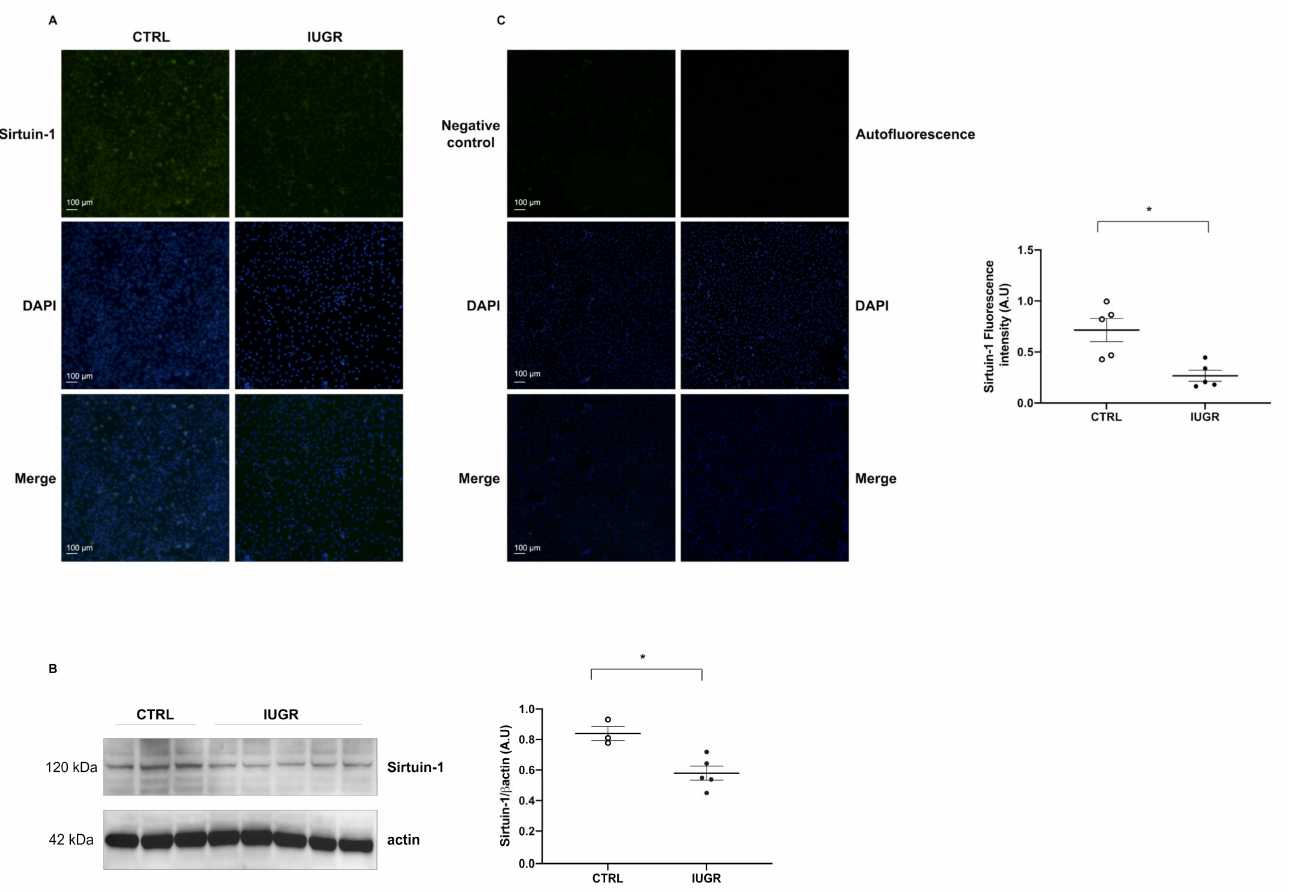
Figure 11. Sirtuin-1 expression. Sirtuin-1 protein expression was measured using immunofluorescence in CTRL-ECFCs and IUGR-ECFCs isolated from six-month-old male rats ( A ). Magnification (20 × ). Nuclei were counterstained with DAPI, and a negative control (with no primary antibody) and a test of autofluorescence were performed ( C ). These pictures are representative images from n = 5 animals/group; * p < 0.05. Scale bar = 100 µ m. In addition, the sirtuin-1 protein expression was measured using western blot in CTRL-ECFCs and IUGR-ECFCs isolated from six-month-old male rats ( B ); n = 3–5 animals/group; * p <